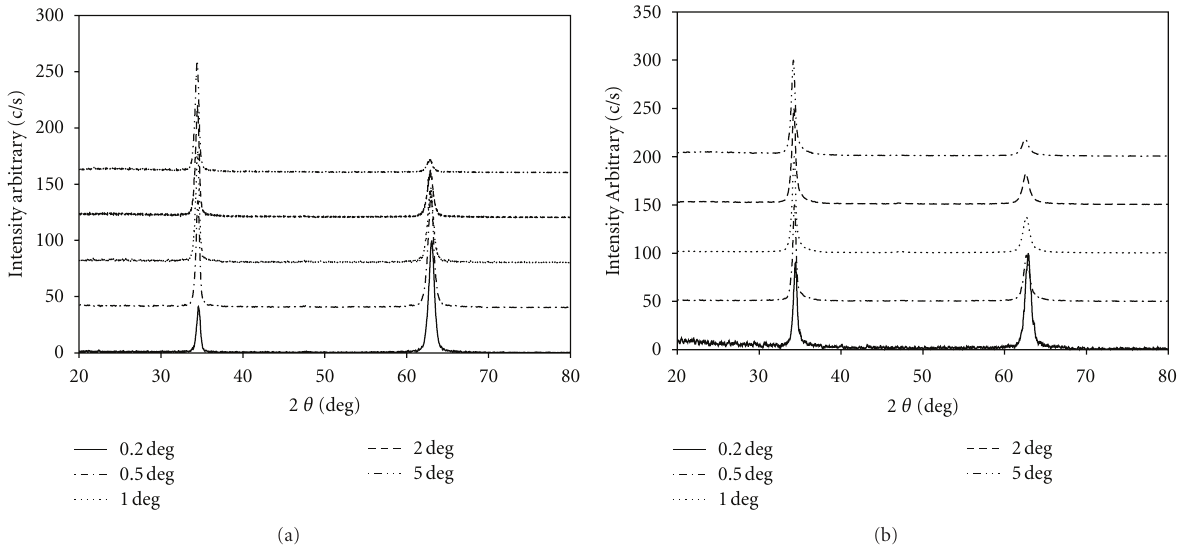
Figure 9: Grazing angle θ /2 θ XRD scans taken at di ff erent angles for thin films grown from (a) ceramic targets. Film thickness is 1.0 μ m (b) powder targets. Film thickness is 1.0 μ m.